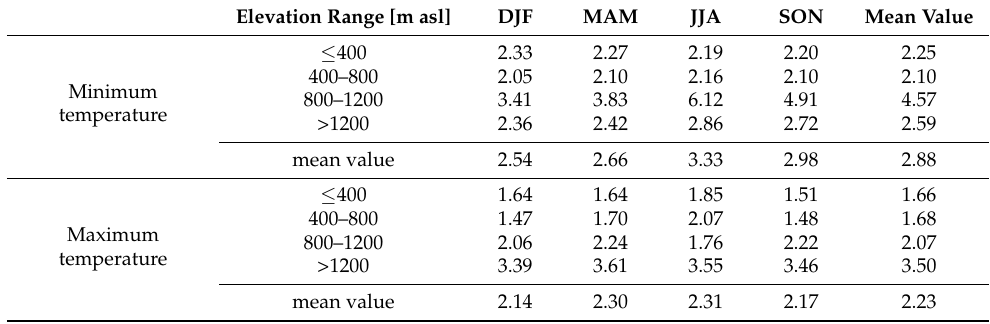
Table 3. ITGD performance results: minimum and maximum temperature MAE [°C] per elevation class.